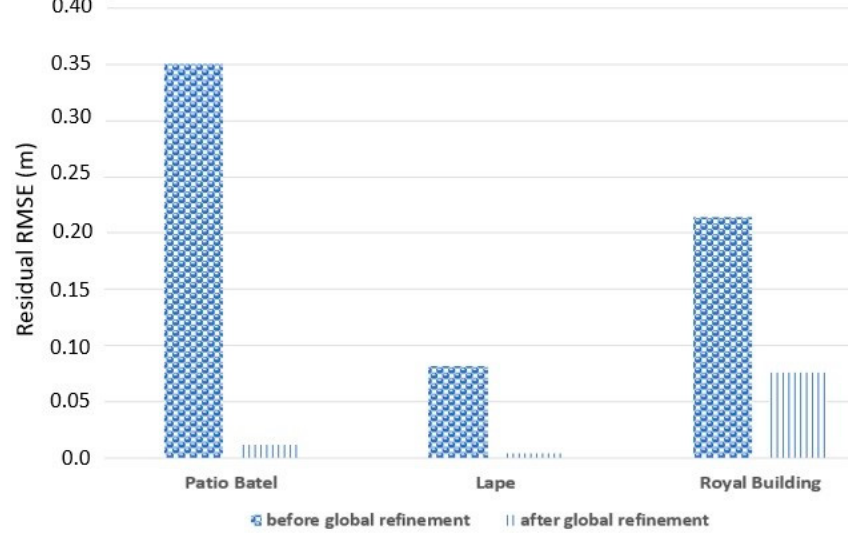
Figure 10. The RMSE of the registration point clouds before and after the global refinement.